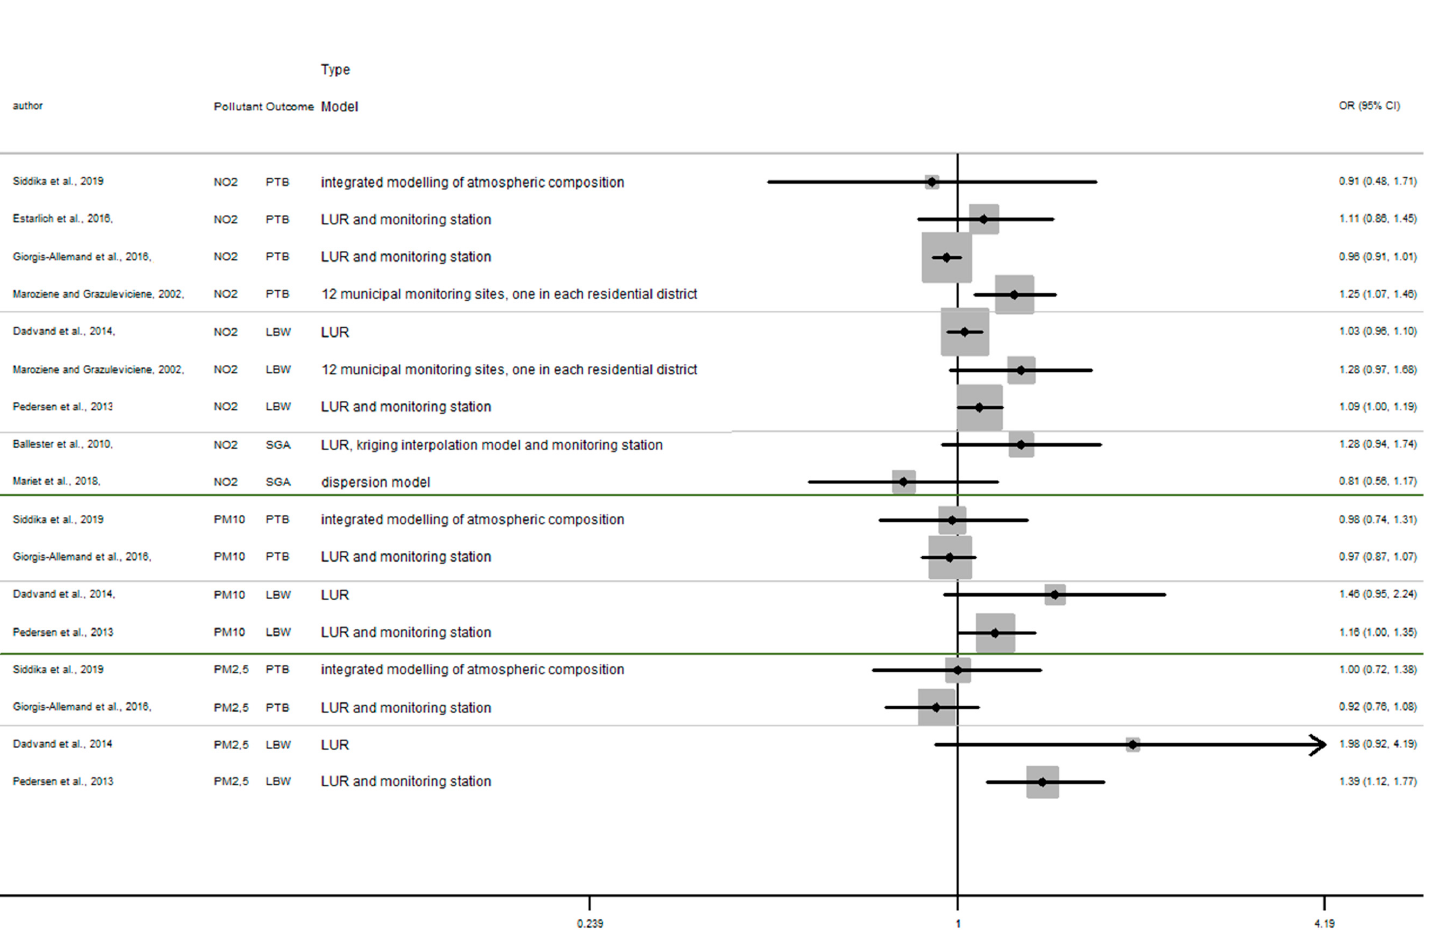
Figure A1. Risk of birth outcome for air pollutant exposure during overall pregnancy.